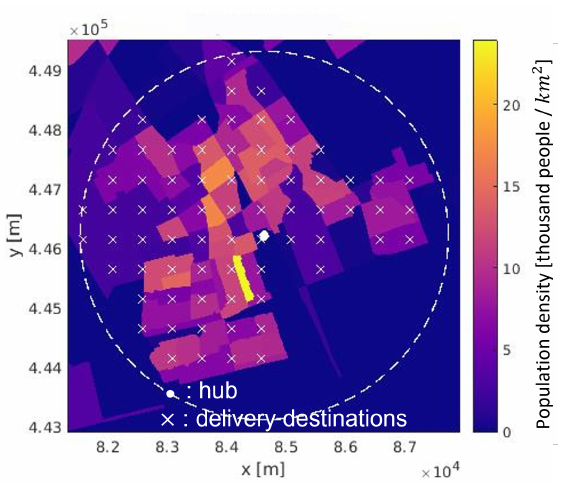
Figure 1. Generated OD pairs (hub-delivery destinations) in the